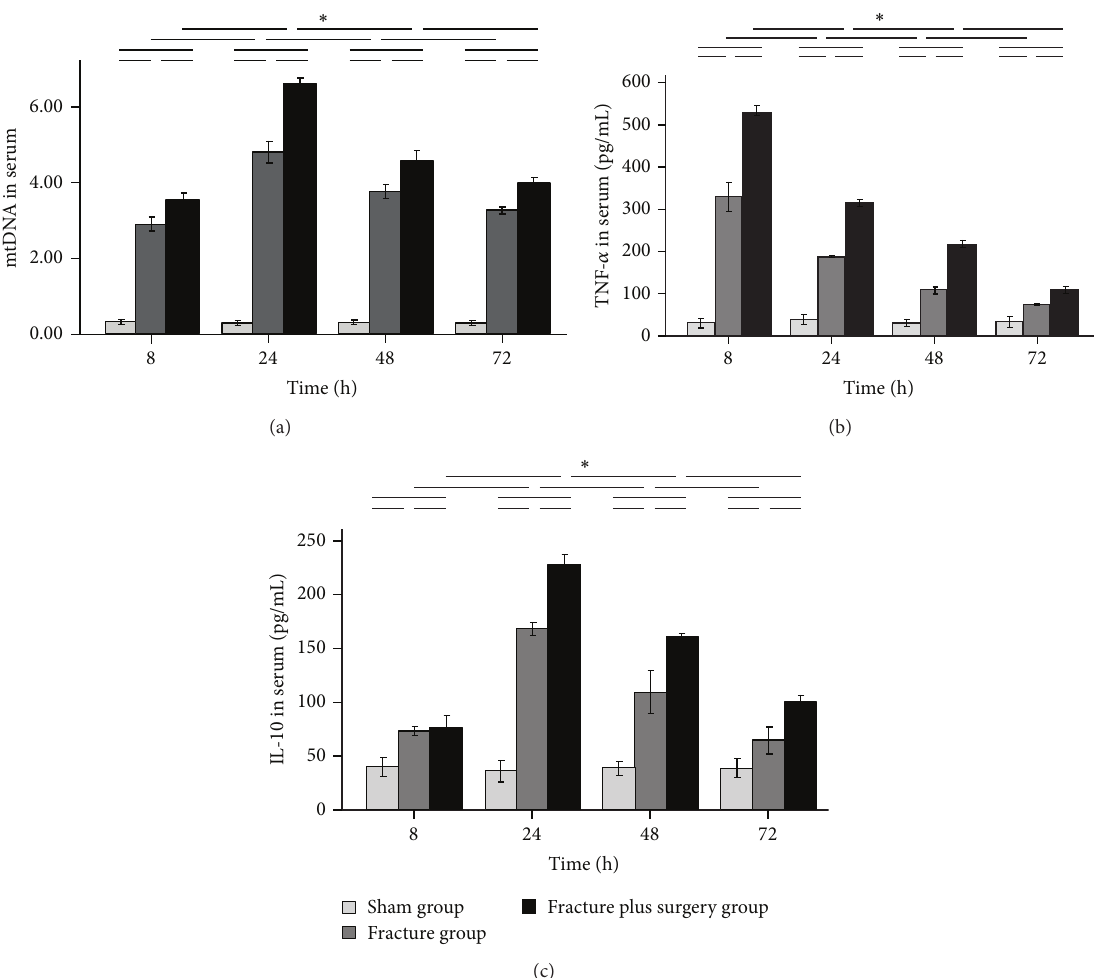
Figure 1: Time course of serum mtDNA (a), TNF- 𝛼 (b), and IL-10 (c) levels. Results are expressed as mean ± standard error. ∗ 𝑃 < 0.05 when compared to other